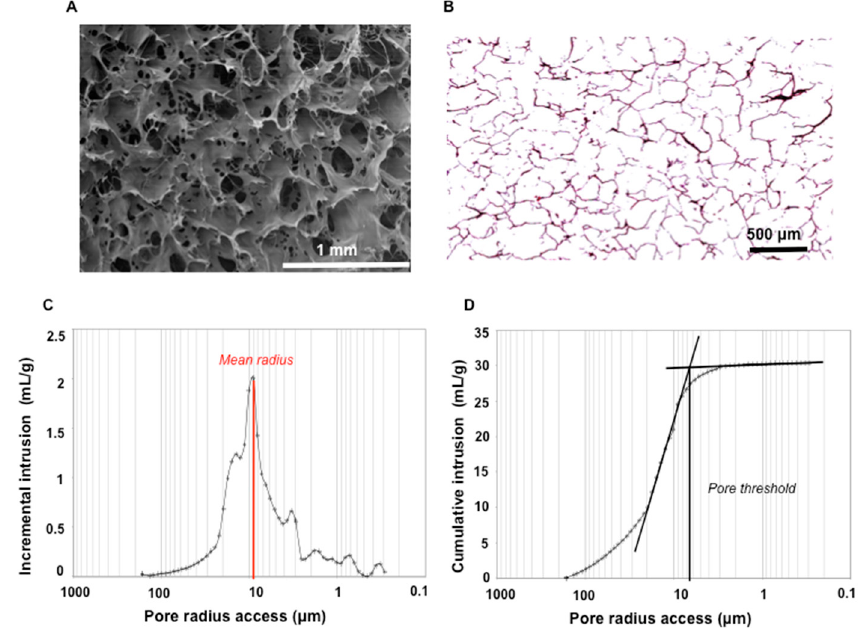
Figure 2. Structure of HEMOCOLLAGENE ® . ( A ) Representative scanning electron microscopy image (SEM, scale bar indicates 1 mm); ( B ) Hematoxylin-Eosin-Saffron (HES) staining of paraffin-embedded HEMOCOLLAGENE ® cross-section (scale bar indicates 500 μ m); ( C , D ) Pore distribution obtained by mercury intrusion porosimetry showing the mean radius on the incremental curve and the pore threshold on the cumulative curve.